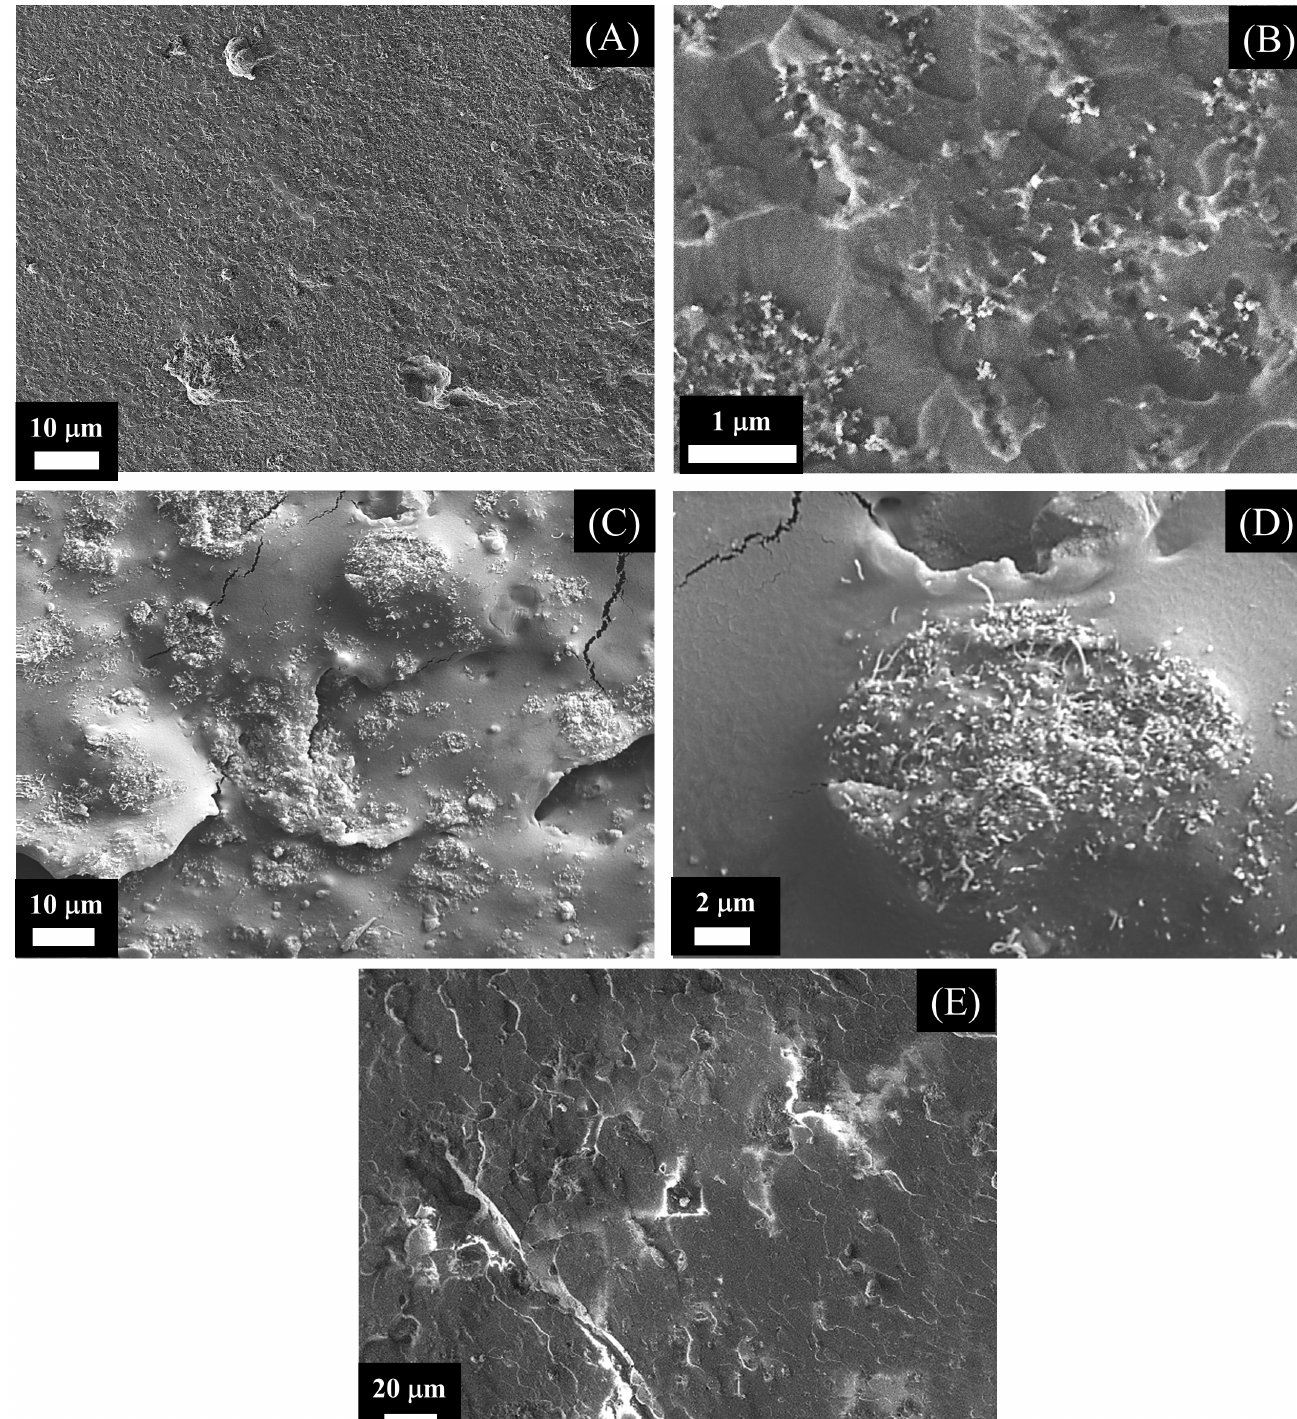
Figure 2. SEM microimages of ( A , B ) PUR/CB and ( C , D ) PUR/MWCNT nanocomposite samples with 5 mass% of conductive nanofillers and ( E ) Neat